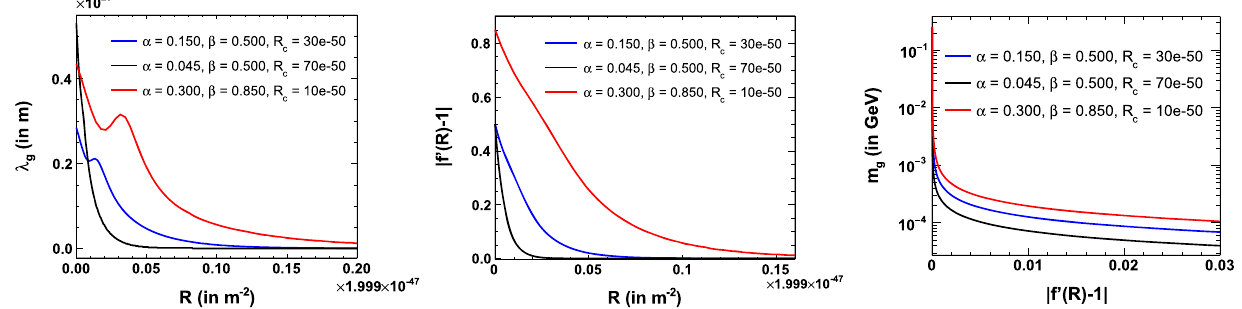
0 . 500 , R c = 70 × 10 − 50 m − 2 ; (iii) α = 0 . 300 ,β = 0 . 850 , R c = 10 × 10 − 50 m − 2 . These are the constrained set of parameters of our model that is done on the basis of upper bounds on f (cid:2) ( R ) − 1 [26] and λ g